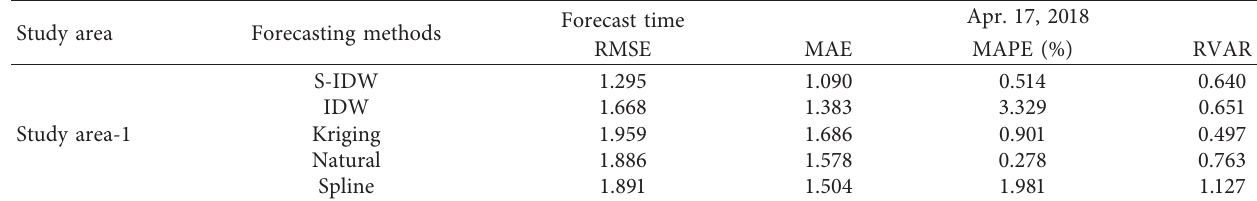
Table 7: Comparison of interpolation accuracy of 5 kinds of interpolation methods on Apr. 17, 2018.